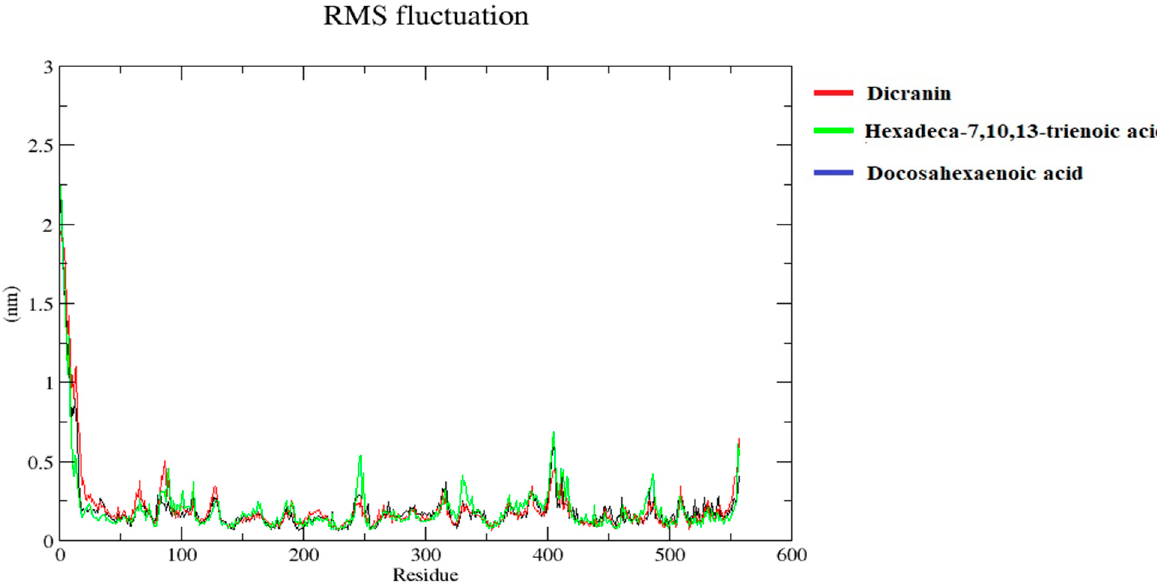
Figure 13. Root mean square fluctuations (RMSF). RMSF plots are presenting the stability of the protein structure. RMSF of protein structure of B. cinerea lipase complex, with dicranin (red), docosahexaenoic acid (blue), and hexadeca-7,10,13-trienoic acid (green), are represented.